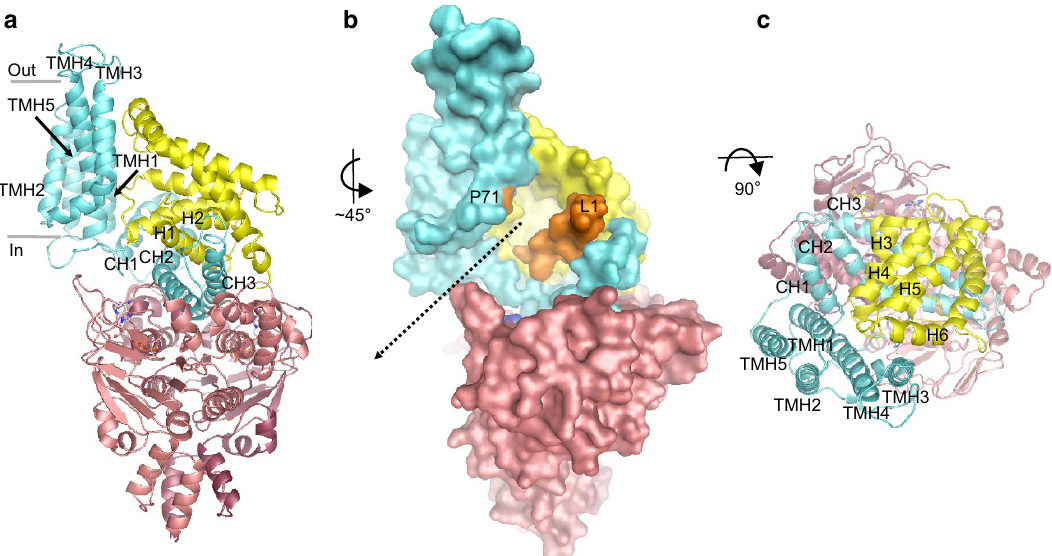
Figure 3 | Crystal structure of AMP–PNP bound ECF–FolT2. ( a ) Cartoon representation of ECF–FolT2 viewed from the plane of the membrane, with EcfA and EcfA 0 coloured in two shades of red, EcfT in cyan and FolT2 in yellow. AMP–PNP molecules are shown in sticks representation, with the carbon and phosphor atoms coloured grey and orange, respectively. The transmembrane helices of EcfT are indicated by TMH1-5 and the three coupling helices by CH1-3. ( b ) Surface representation using the subunit colours from a . Loop L1 of FolT2 and proline 71 (P71) in TMH3 of EcfT are coloured orange. The pathway leading from the open folate-binding cavity to the cytosol is indicated by the dashed arrow. ( c ) View along an axis perpendicular to the membrane.